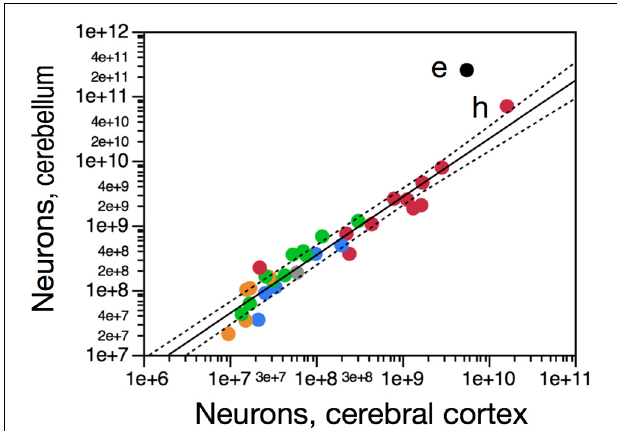
FIGURE 5 | The African elephant brain has a 10 times larger ratio between cerebellar and cortical neurons than other mammalian species. Figure shows how number of neurons in the cerebellum varies homogeneously as a function of number of neurons in the cerebral cortex across species. Elephant data point shown in black (e), other afrotherian species in blue, primates in red (human, h), eulipotyphlans in orange, and glires in green. Data from (Herculano-Houzel et al., 2006, 2007, 2011; Azevedo et al., 2009; Sarko et al., 2009; Gabi et al., 2010; Neves et al.,